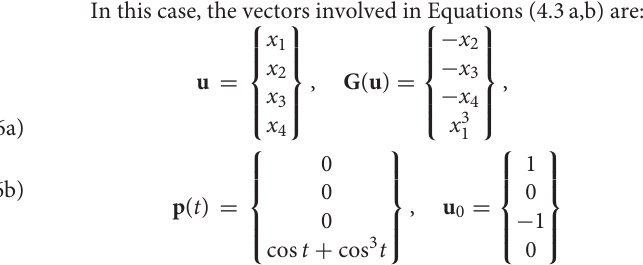
FIGURE 11 | (A) The heliocentric coordinate system ( r , θ ) for the ellipse in Example 11. (B) Plot of the solution using polar coordinates in Example 11. (C) Plot of the r r ex in Example 11. (E) Orbit of a planet when the mass of the planet or the mass of Sun varies with time in Example 11. solution r ( t ) in Example 11. (D) Error = − Example 12. Fourth-Order